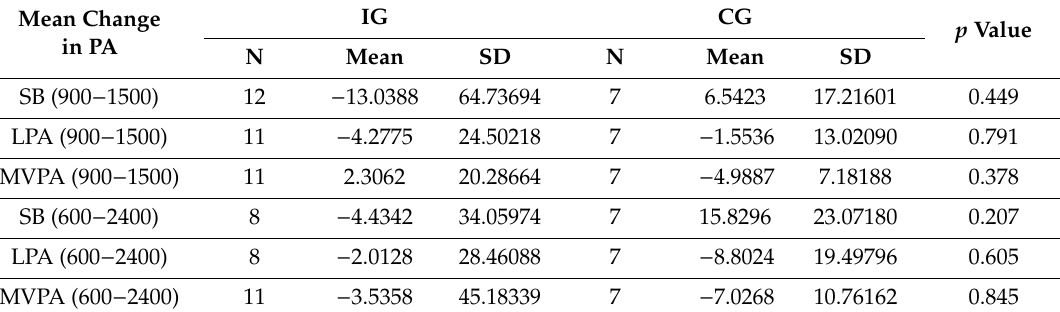
Table 5. Mean change in physical activity (minutes) over